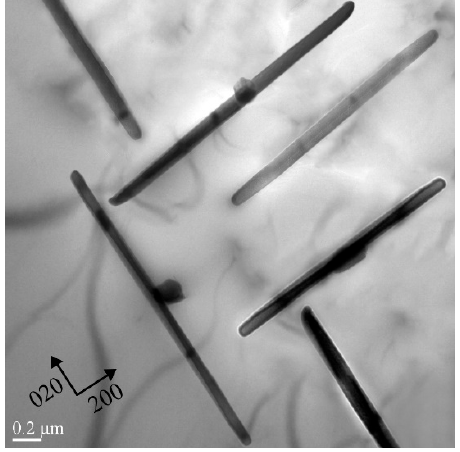
Figure 9. Bright-field TEM image of precipitates in the PM casting samples; isothermal holding at nose temperature (350 °C) for 300 s, recorded near [001] direction.